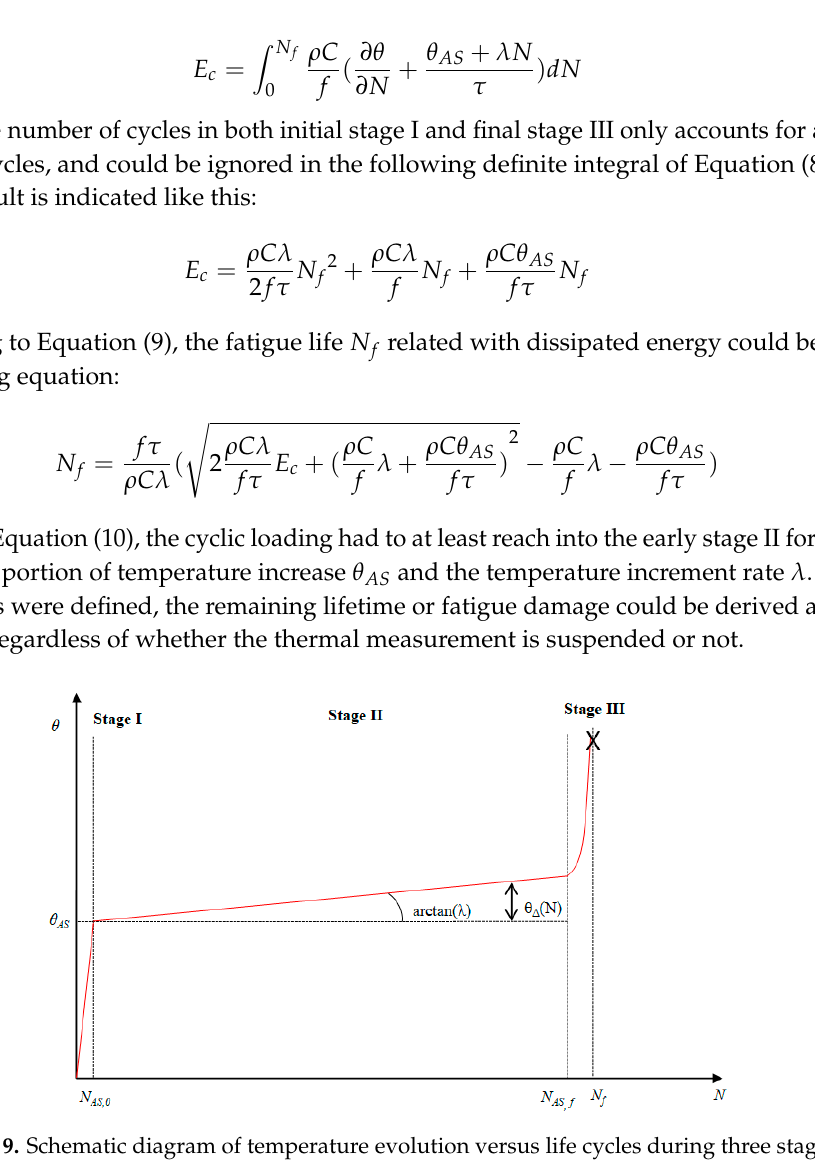
Figure 9. Schematic diagram of temperature evolution versus life cycles during three stages.